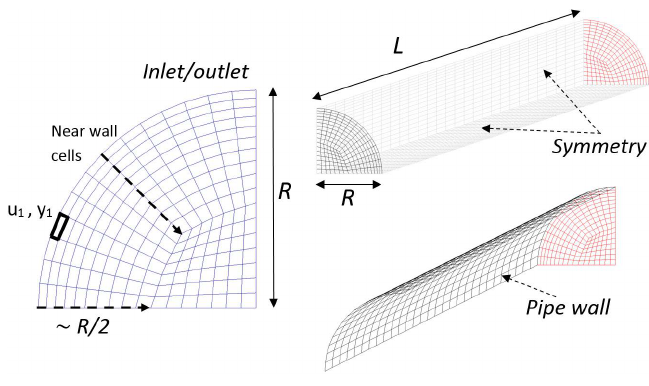
Figure 5. The computational